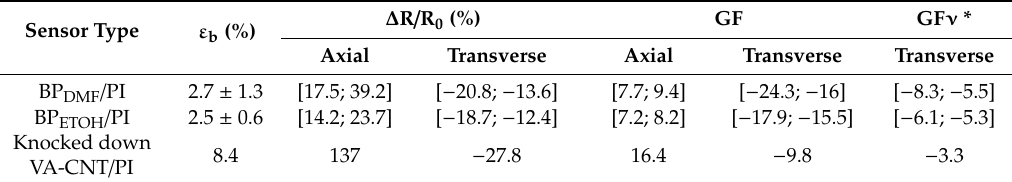
Figure 6. Gauge factor (GF) versus strain ε for the BP DMF /PI samples (GF strain and GF opp values in axial strain and opposite (transverse) directions, respectively).